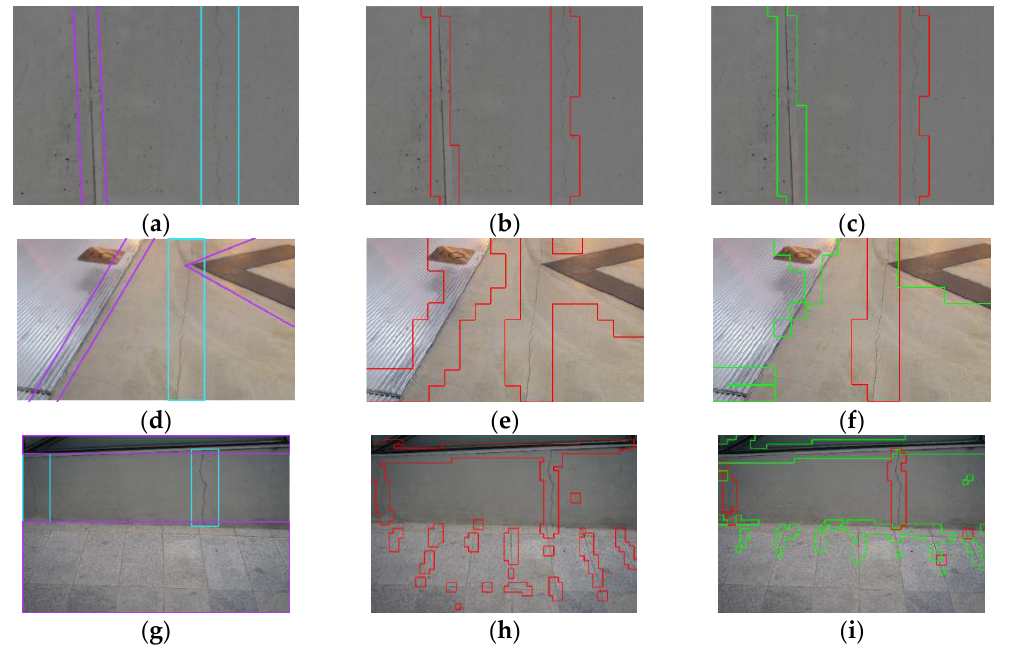
Figure 8. Examples to present enhancement by Joint/Edge Class: ( a , d , g ) original images, ( b , e , h ) classification results with two classes, Crack and Surface, and ( c , f , i ) enhanced classification results with introducing Joint/Edge(SL) class. Sensors 2018 , 18 , x